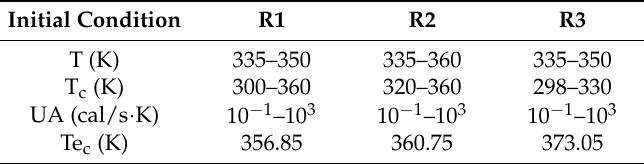
Table 5. Search regions used for parameter